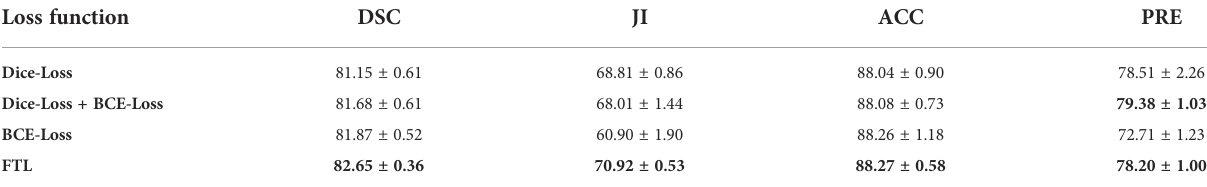
TABLE 5 Effectiveness experiment of FTL loss function.